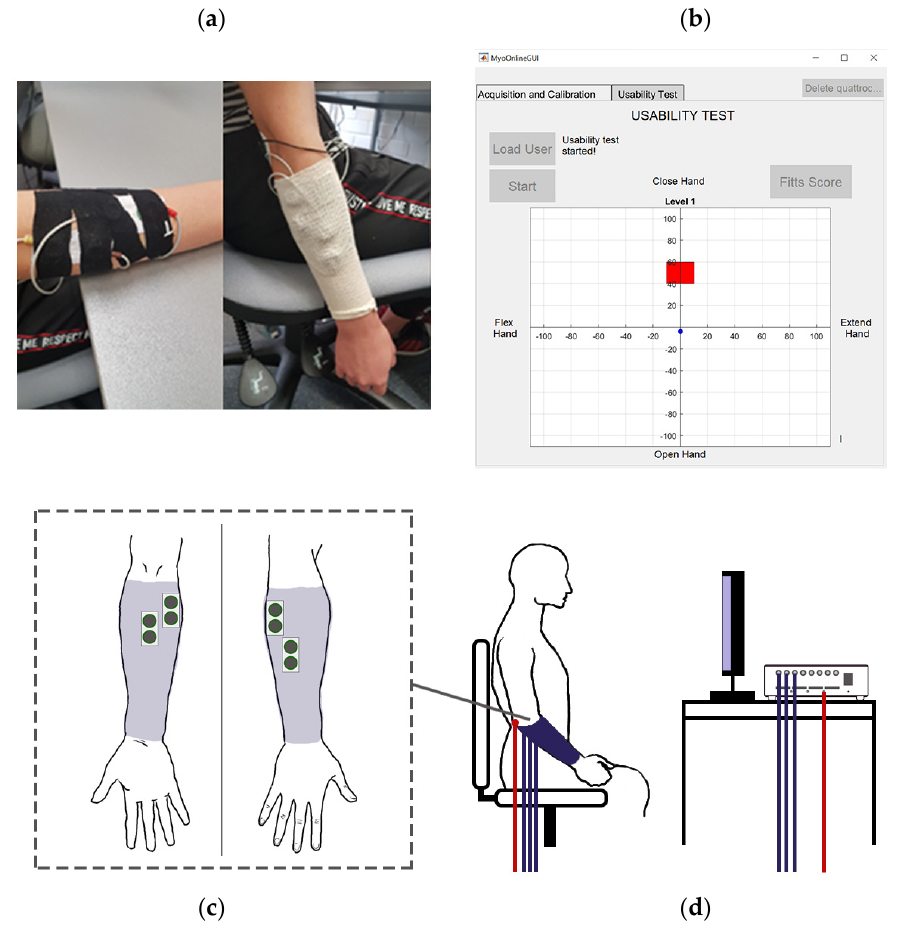
Figure 2. Experimental setup. ( a ) The electrodes are first placed with kinesiology tape and then secured with a bandage. ( b ) Usability test with the blue cursor and red target. ( c ) Positions of electrodes on the anterior and posterior sides of the right forearm. ( d ) Subject arrangement.